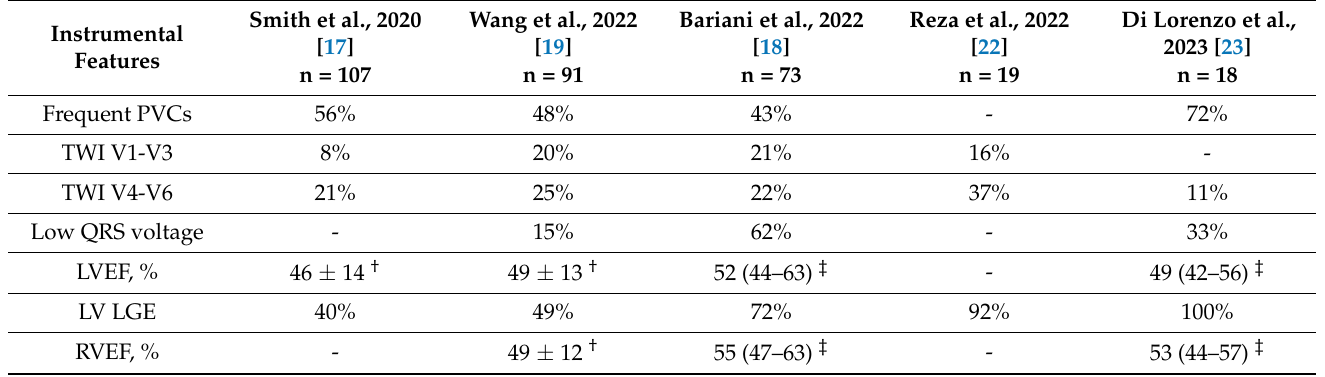
Table 2. Electrocardiographic and imaging features of DSP